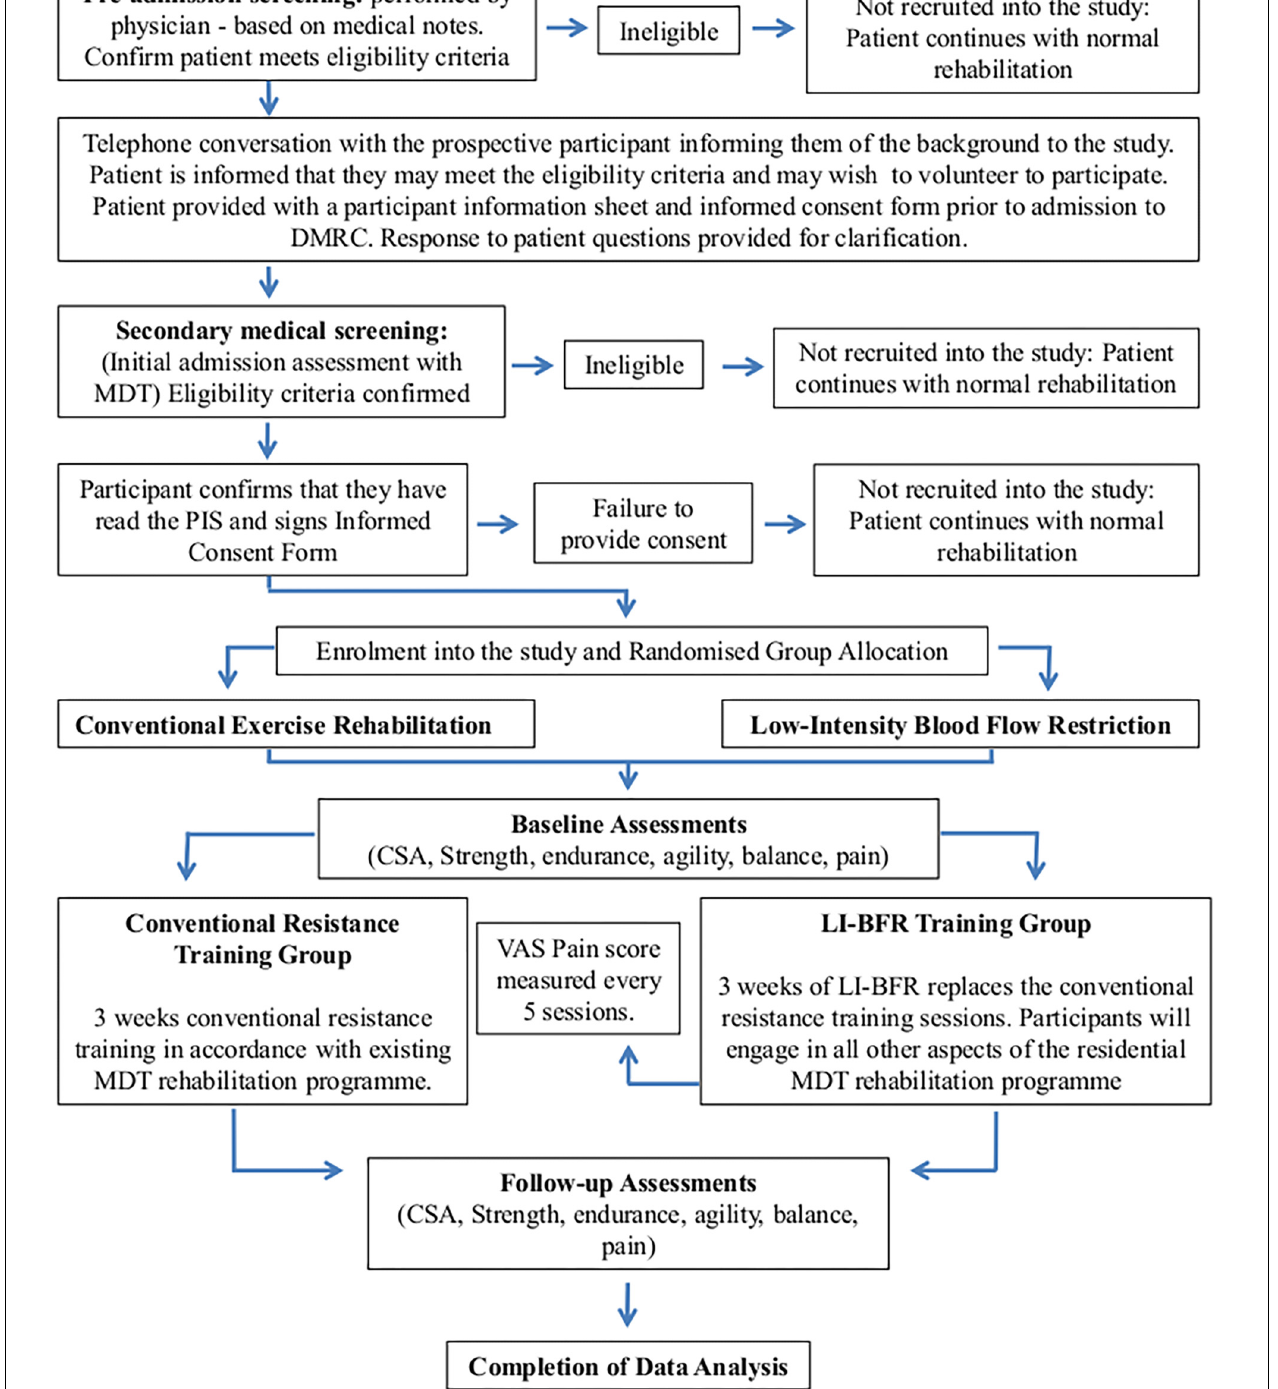
FIGURE 1 | Study protocol and participant